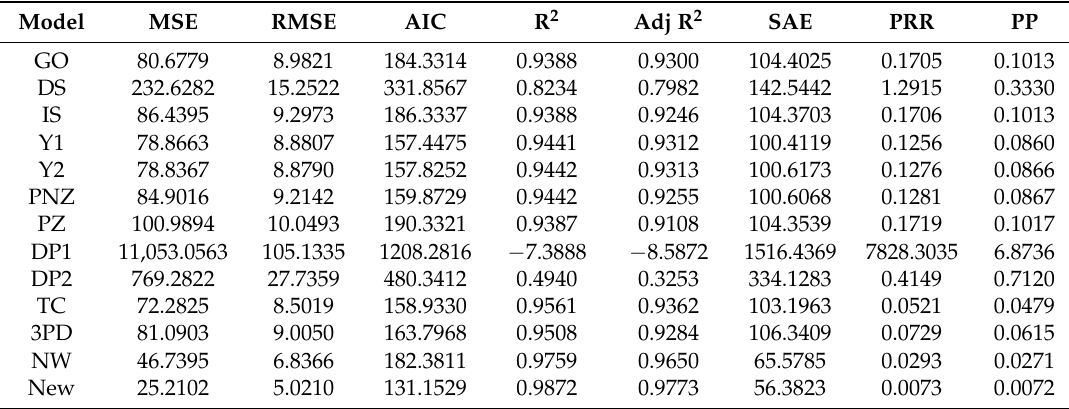
Table 7. Comparison criteria from LMRS dataset (Dataset #2).